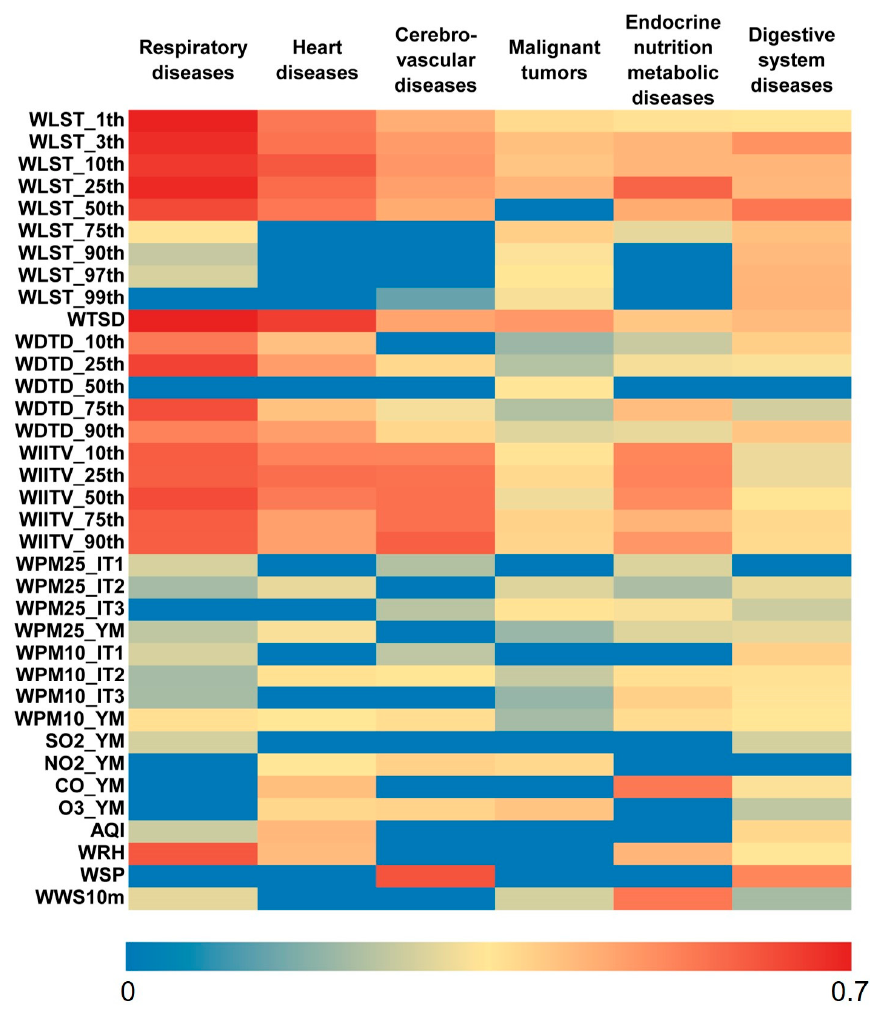
Figure 3. q-value distribution map of exposure indexes. The color of each grid indicates the explana- tory degree of different exposure indicators to the corresponding chronic disease mortality. The dark blue indicates that there is no statistically significant relationship between the corresponding indexes and disease mortality ( p > 0.05) while red indicates high relevance.